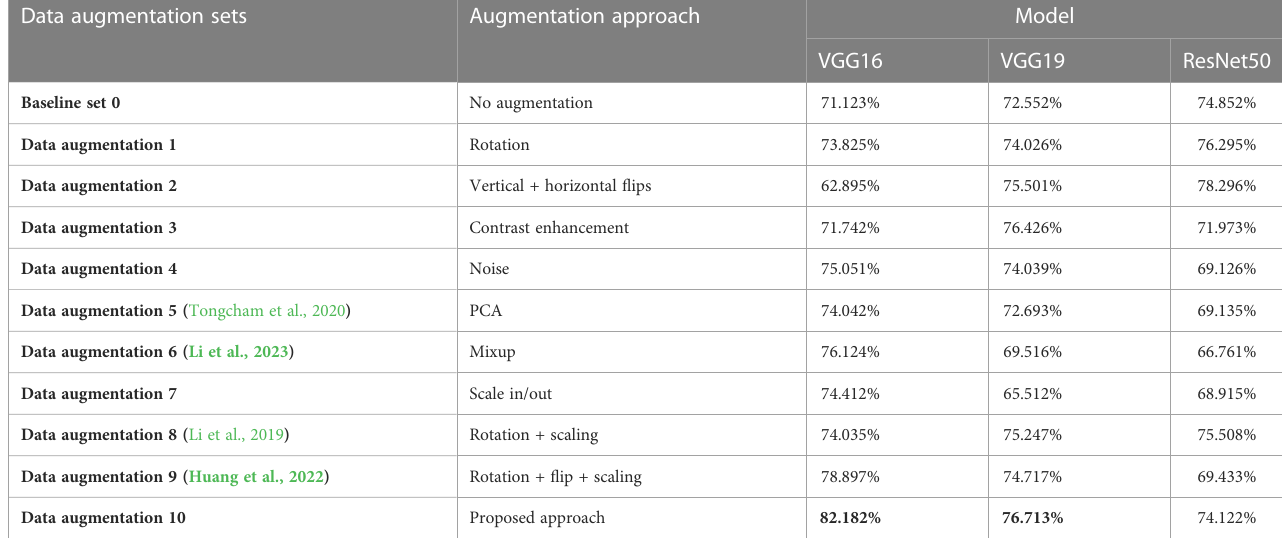
TABLE 3 Comparative analysis of different benchmarking models through validation accuracy of different machine vision